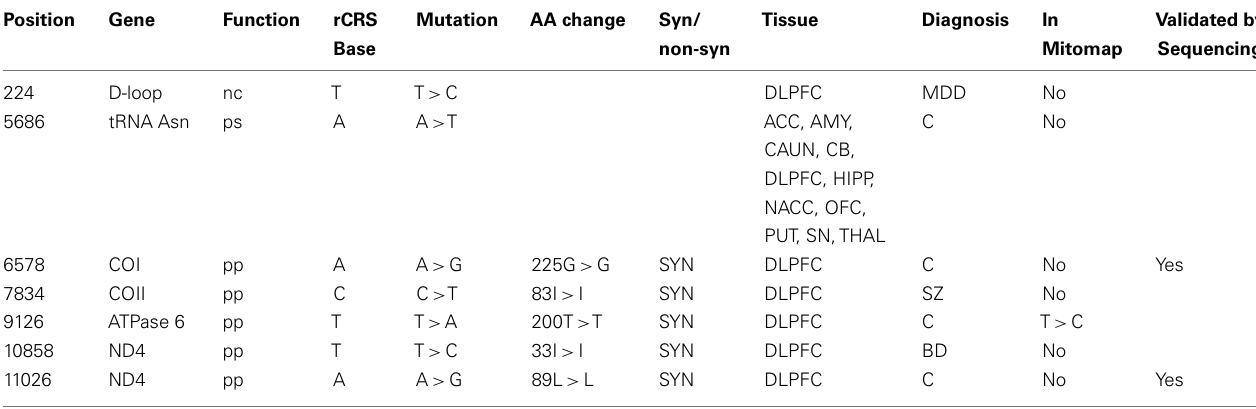
Table 2 | Novel mitochondrial homoplasmic mutations (7) found in brain of neuropsychiatric patients and controls detected with Illumina sequencing.